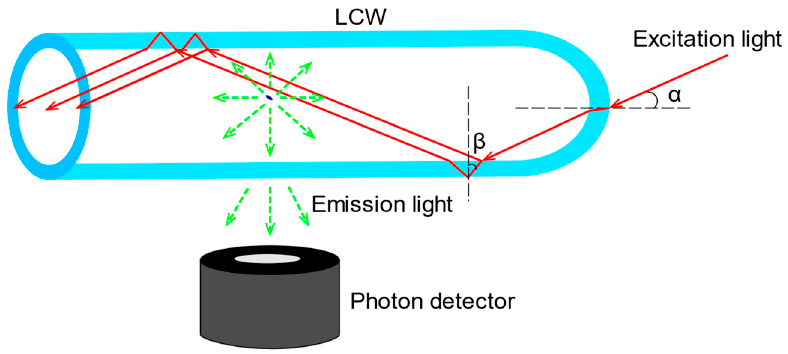
Figure 5. Schematic of the LCW, performing the simultaneous functions of excitation guiding and emission filtering. The red solid lines represent excitation light while the green dashed lines represent emission light. Provided the incident angle α is appropriate, only emission light is allowed to reach the detector.